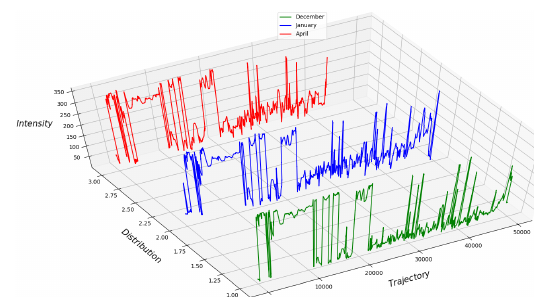
Figure 15. Measured light values for the Deva to Pites Sibiu) segment of A1-DN7 oara to Three light intensity measurements are considered , with the trajectory tensor having the following representation: